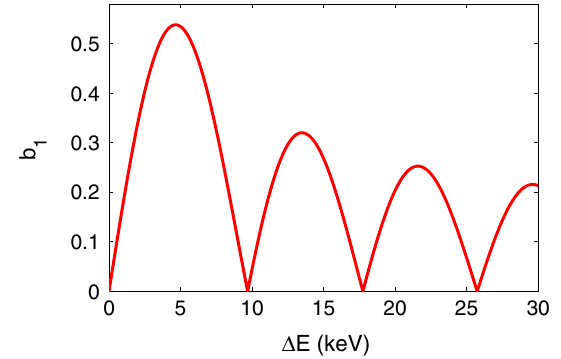
FIG. 1. Bunching at the fundamental frequency for various energy